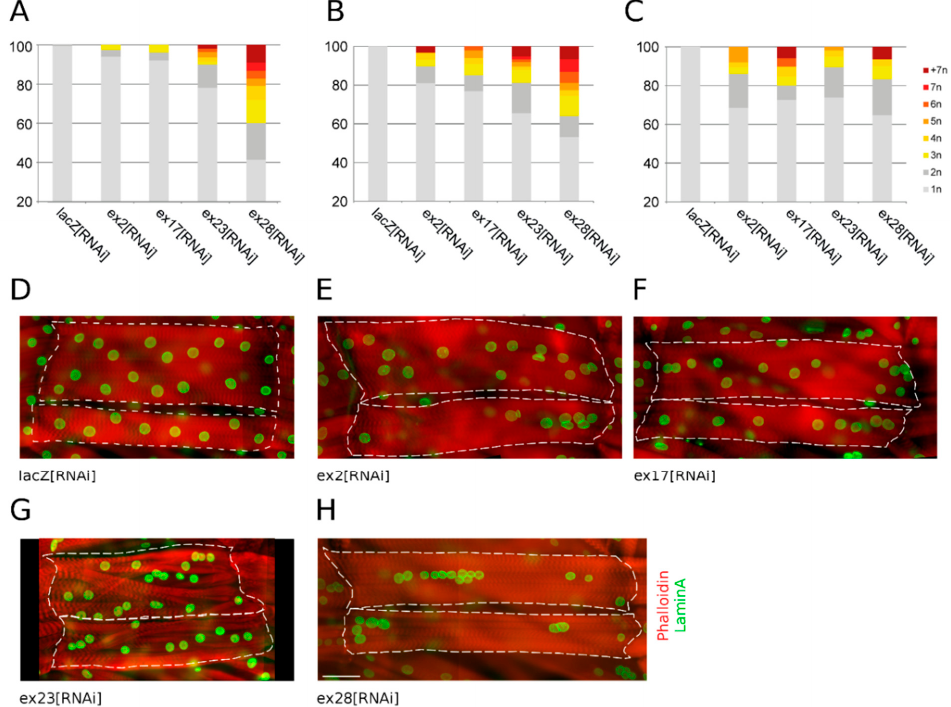
Figure 3. Msp300 isoform depletion differentially alters nuclei positioning in the muscle. ( A – C ) Nuclei clustering quantification in fibres 4 ( A ), 6 ( B ) and 7 ( C ), comparing the effects of muscular expression of either lacZ[RNAi] or Msp300[RNAi] and showing the percentage of total nuclei found isolated or in groups of two to more than seven nuclei. Percentage of nuclei involved in clusters and size of the clusters vary with the RNAi and the muscle type used. Number of scored larvae and total number of counted nuclei are: lacZ[RNAi]: 9 larvae, 402/483/281nuclei (F4/F6/F7); ex2[RNAi]: 7 larvae, 244/326/188 nuclei; ex17[RNAi]: 6 larvae, 186/263/143 nuclei; ex23[RNAi]: 11 larvae, 357/416/259 nuclei; ex28[RNAi]: 9 larvae, 352/402/246 nuclei. ( D – H ) Immunostaining of muscles 6 and 7 expressing lacZ[RNAi] ( D ), ex2[RNAi] ( E ), ex17[RNAi] ( F ), ex23[RNAi] ( G ), ex28[RNAi] ( H ) showing representative nuclei clustering phenotypes. Nuclei labelled with LaminA antibody (green) and contractile apparatus with phalloidin (red). Fibres are outlined with white dotted lines for ease of identification. In each panel, Fibre 6 on top and 7 below, anterior left. Scale bar on ex28[RNAi] panel: 100 µm.